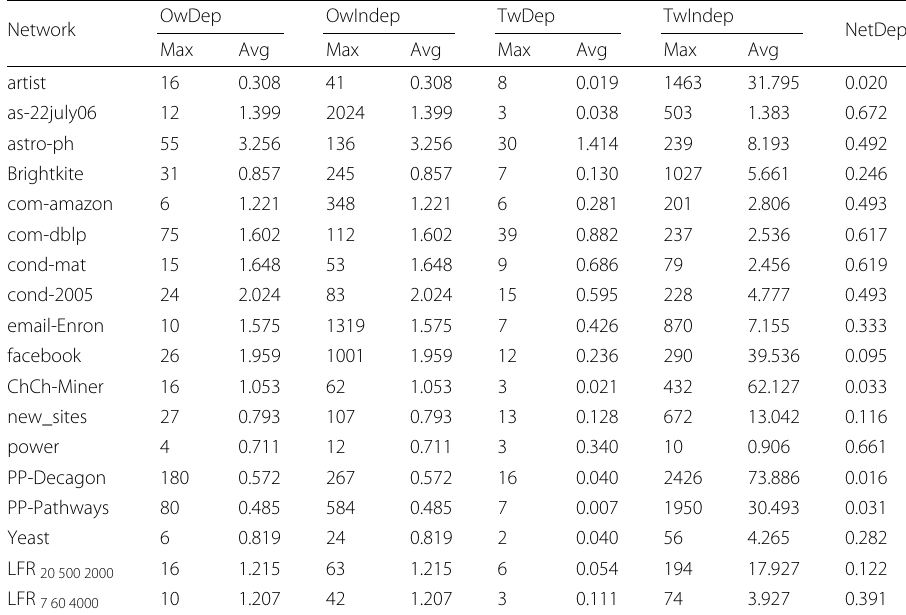
Table 12 Node dependencies and network dependency in real-world networks Network